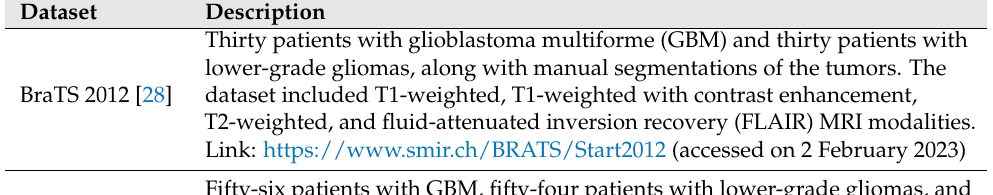
Table 2. Description of BraTS datasets from 2012 to